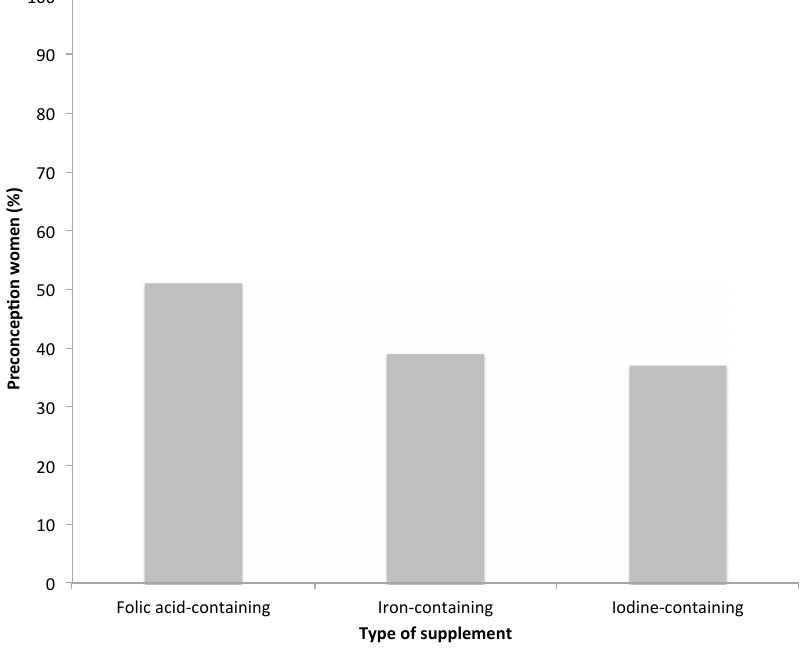
Figure 2. Nutrient-containing dietary supplement use among preconception women aged 31–36 years in 2009 from the Australian Longitudinal Study on Women’s Health. Participants were able to select multiple supplements, therefore numbers do not add to 100%. Nutrients from dietary supplements includes nutrients from both multiple micronutrient and single nutrient supplements.